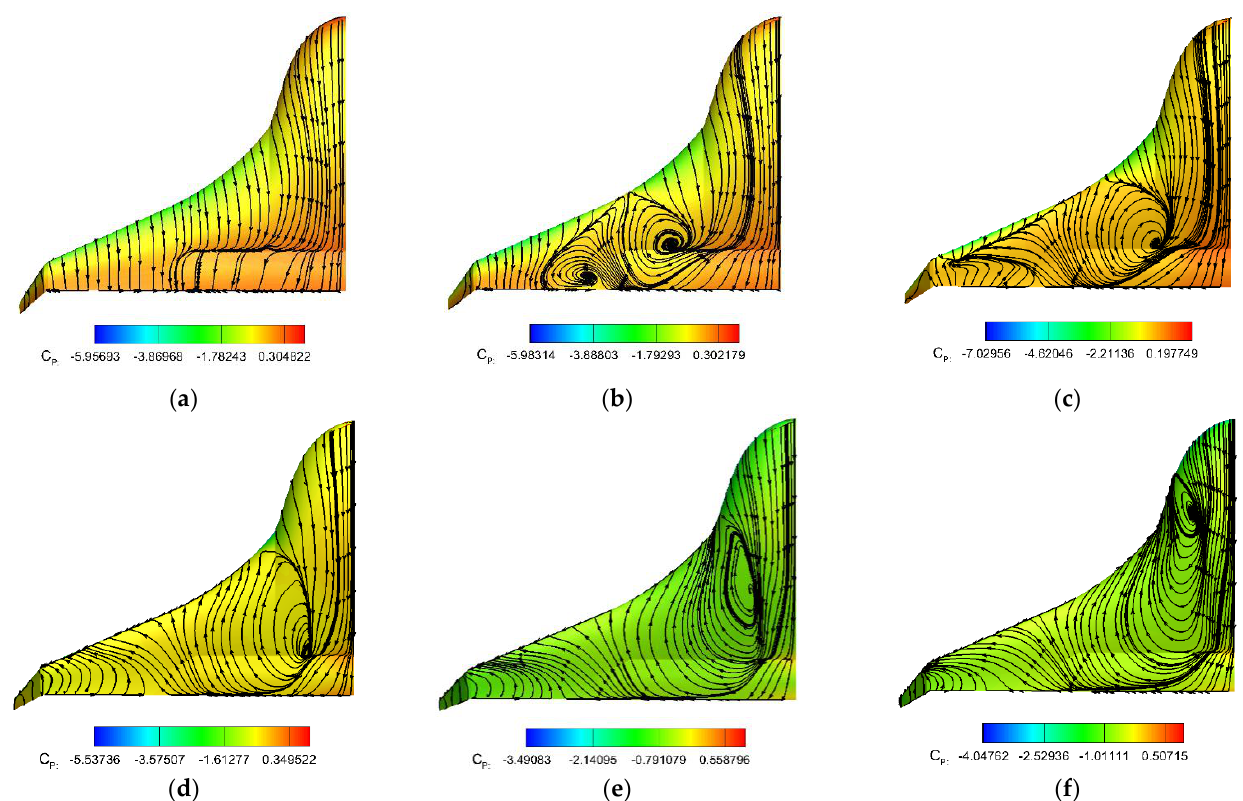
Figure 16 . Numerical surface flow distribution development with angle of attack. ( a ) α = 8°. (b) α =